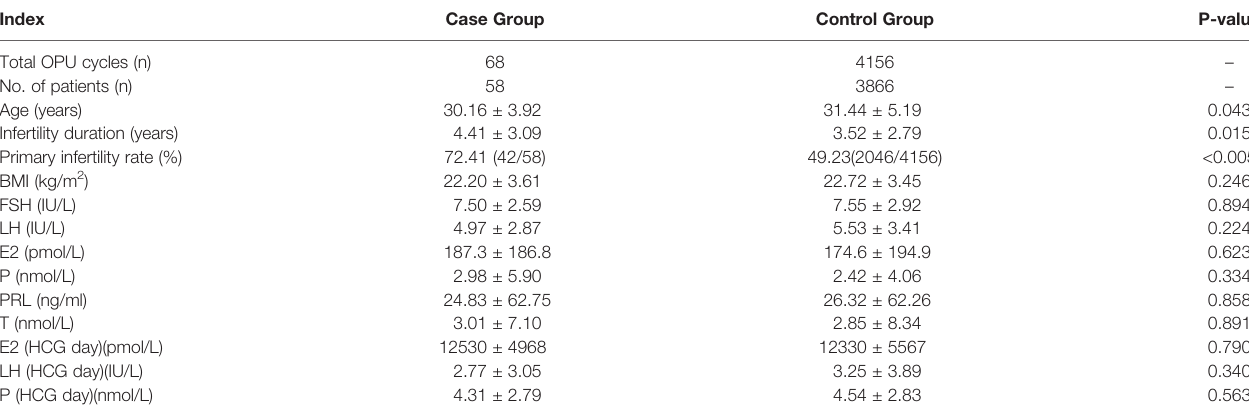
TABLE 1 | Basic clinical information of